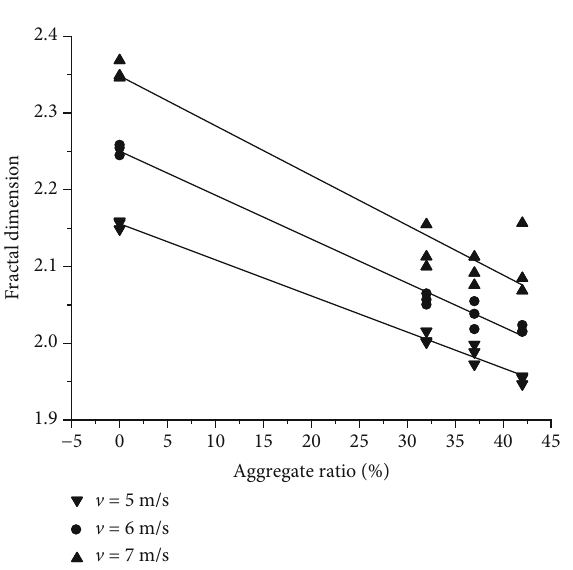
Figure 7: Relationship between aggregate rates and fractal